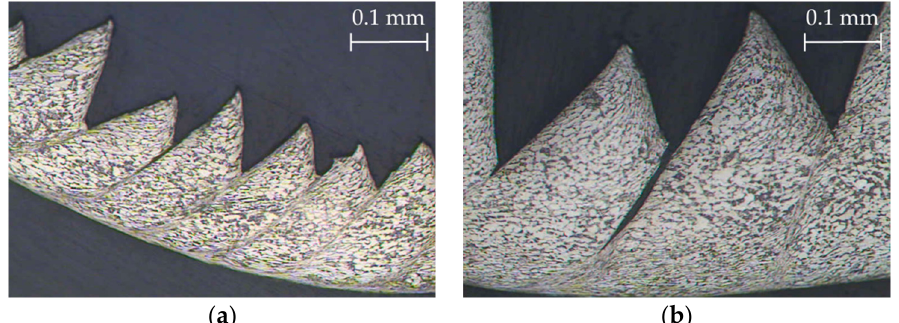
Figure 9. Chip microstructure (20×) at v c = 125 m/min: ( a ) f = 0.20 mm/r, and ( b ) f = 0.30 mm/r.